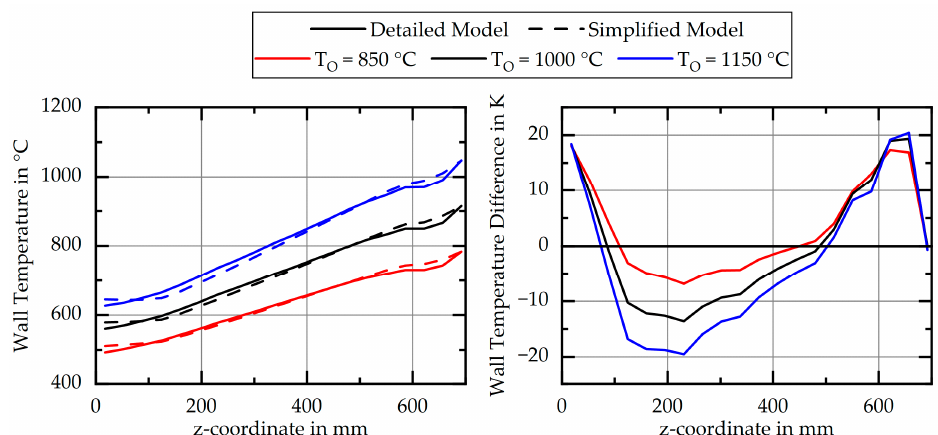
Figure 19. Average wall temperature of the offgas guiding tube in the detailed and the simplified model and absolute difference between the temperature in the models over the length of the tube for P = 160 kW and λ = 1.15.